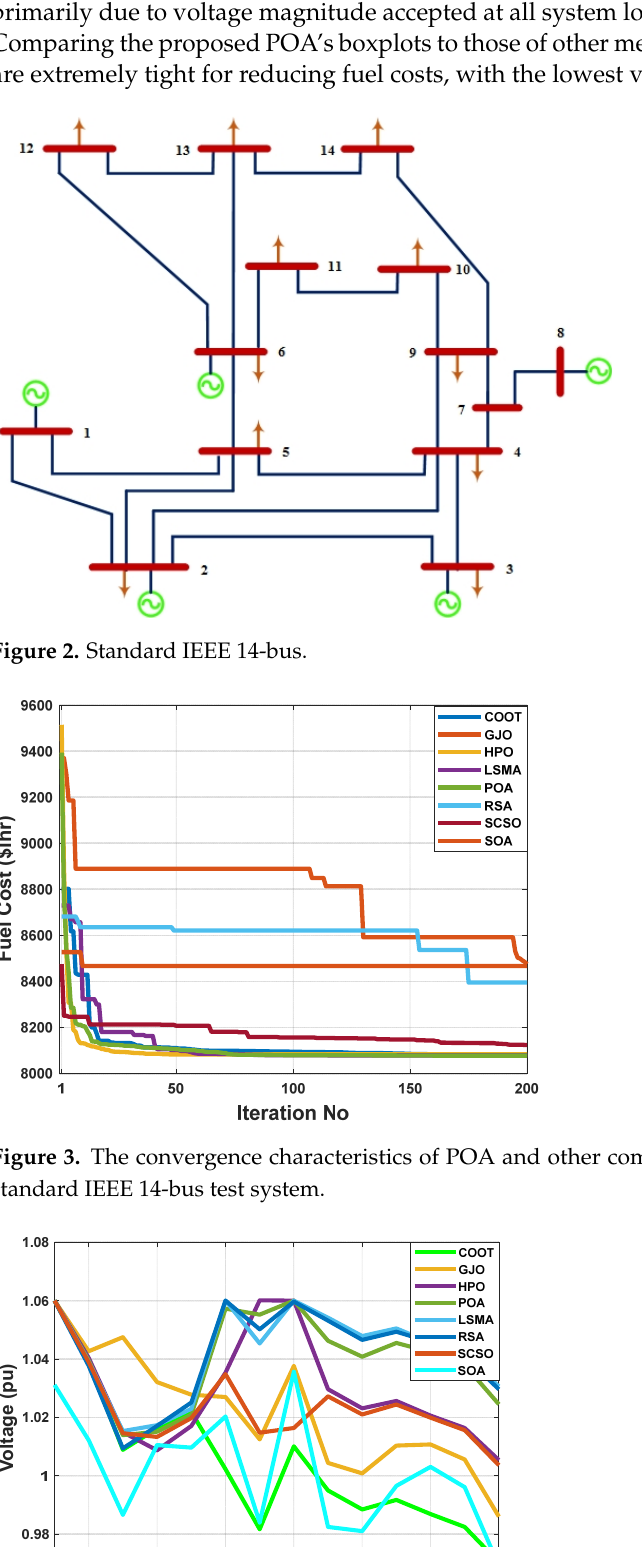
Table 2. Optimal control variables for IEEE 14-bus test system for minimizing fuel cost.